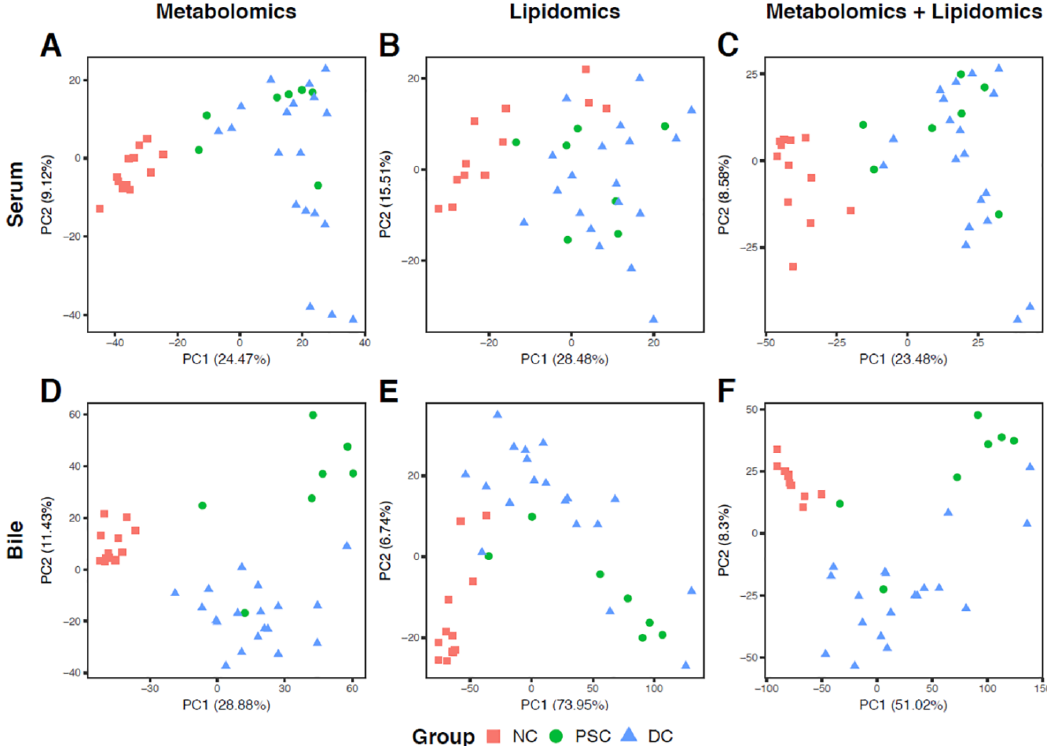
Figure 1. Principal-component analysis (PCA) ordination plots of metabolomic ( A , D ), lipidomic ( B , E ), and combined ( C , F ) profiles of portal serum ( A – C ) and bile ( D – F ) from patients with primary sclerosing cholangitis (PSC), cirrhotic liver disease (disease control, DC), and from heathy controls (nondisease control, NC). For the ordination of metabolomic data, relative intensities of both annotated and unannotated liquid chromatography-mass spectrometry (LC-MS) peaks were used.